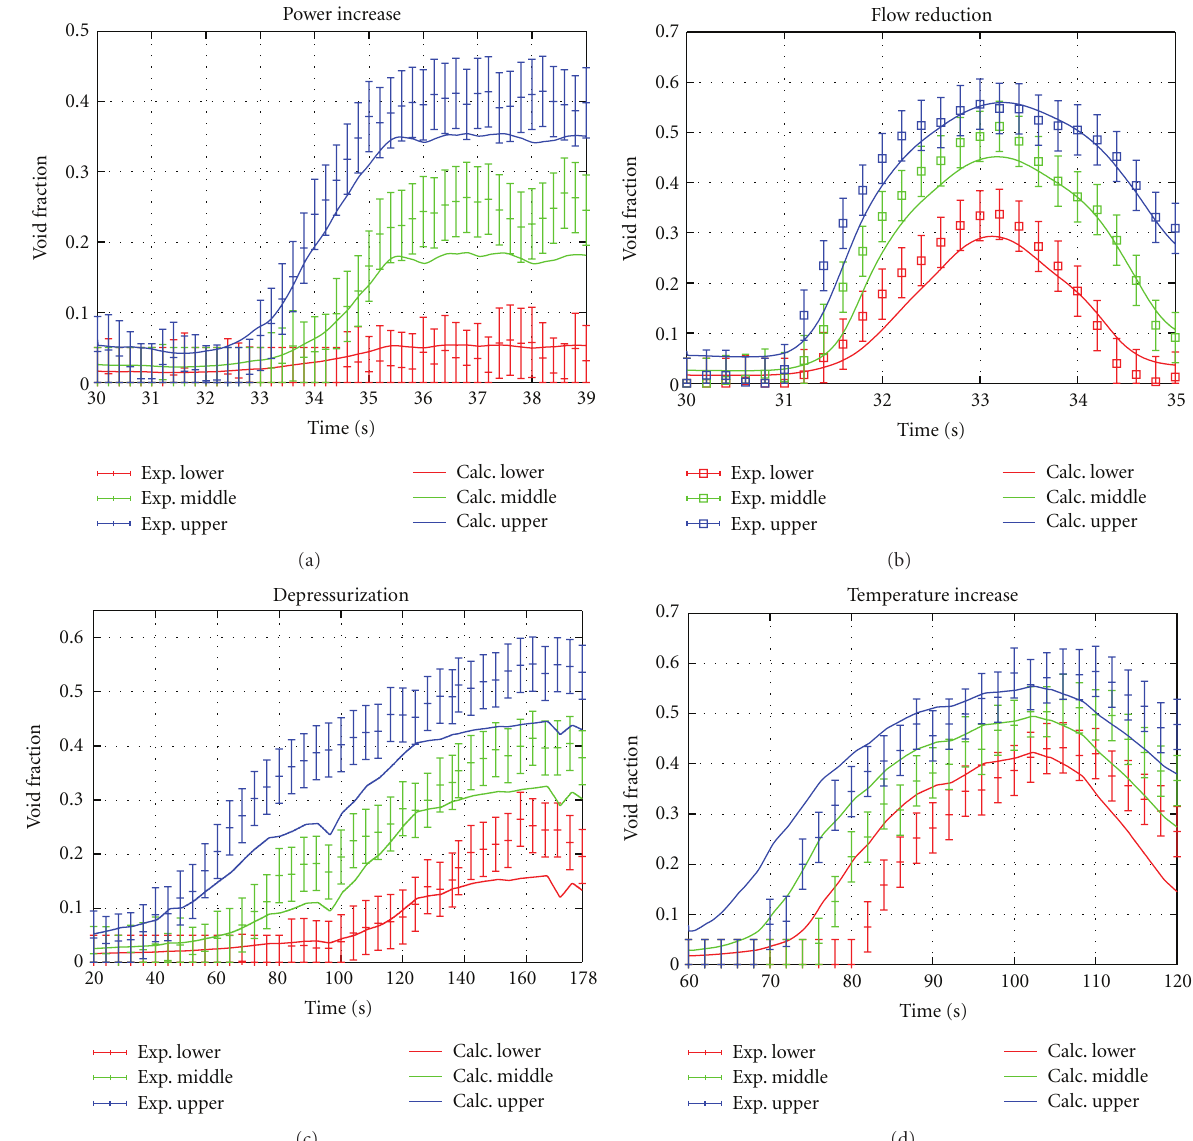
Figure 5: Transient T5: comparison between calculated and measured void